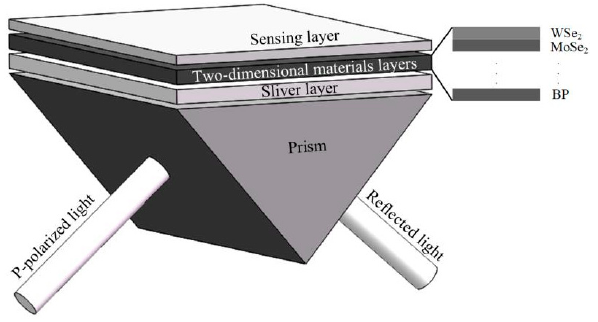
Figure 1. Diagram of an SPR sensor.